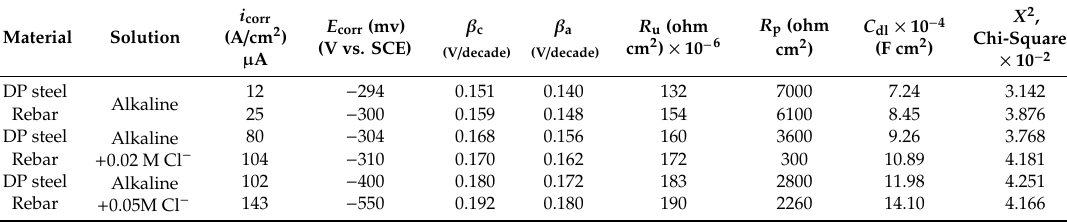
Figure 9. EIS Nyquist curve in an alkaline solution + 0.05 M Cl − ions. EIS, electrochemical impedance spectroscopy. Table 2. Potentiodynamic polarization and EIS results in an alkaline solution with and without different Cl − ion concentrations.